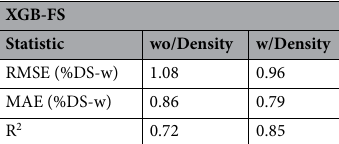
Table 4. Comparison of XGB-FS model performance with and without bulk density parameter.